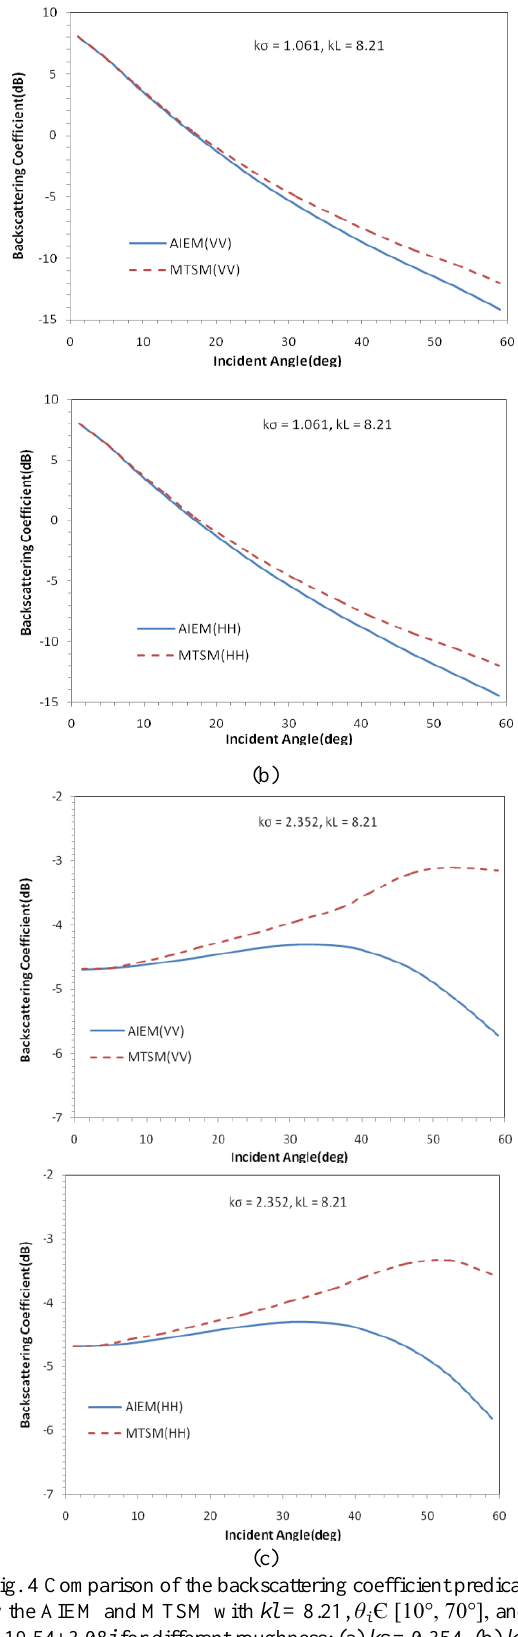
Fig. 4 Comparison of the backscattering coefficient predicated by the AIEM and MTSM with kl = 8.21, θ i Є [10°, 70°], and ε s = 19.54+3.08 i for different roughness: (a) ks = 0.354, (b) ks = 1.061, and (c) ks =